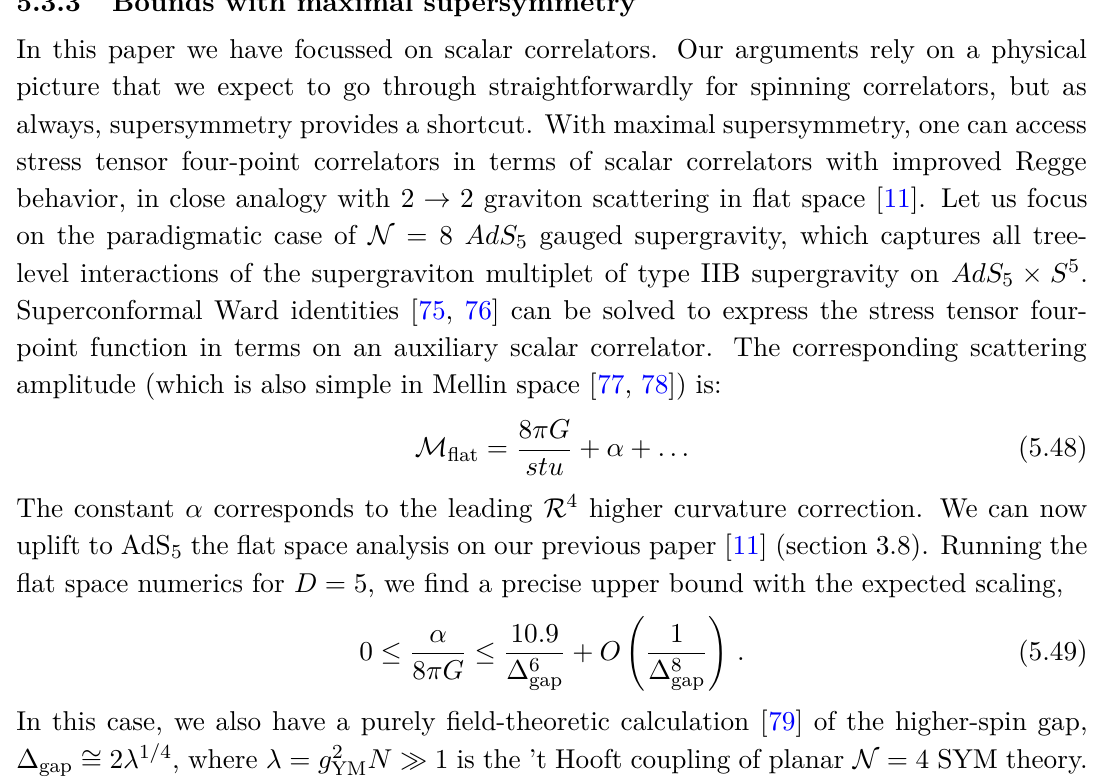
Figure 17. Similar to figure 15 but for the CFT 5 /AdS 6 functionals in eqs. (5.45). The left panel confirms that the improvement terms are again positive on their own for β > b identical, show the flat space approximation of the functionals for β < 2 . The discontinuous curve on the right panel shows that the Regge limit of the original functional is not positive (negative regions show as missing parts in the logarithmic plot), but becomes positive upon including the small perturbation